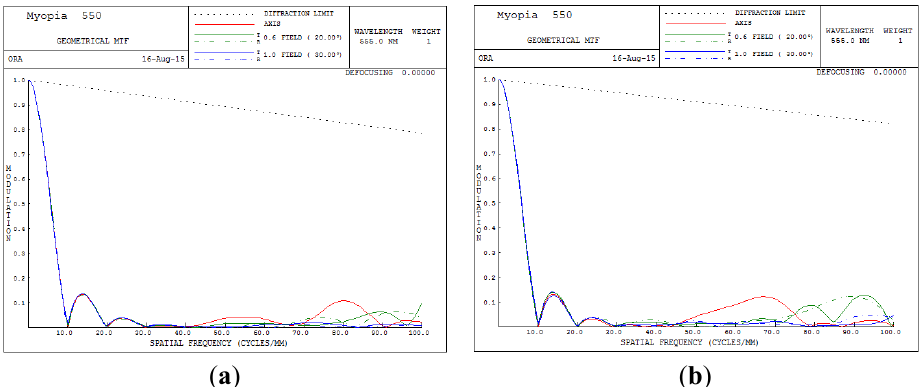
Figure 6. Modulation transfer function (MTF) plot for 550 degrees myopia and 175 degrees astigmatism. ( a ) 5 mm; ( b ) 6 mm. Table 4. The lens parameter after CODE V optimization for pupil size 5 mm.